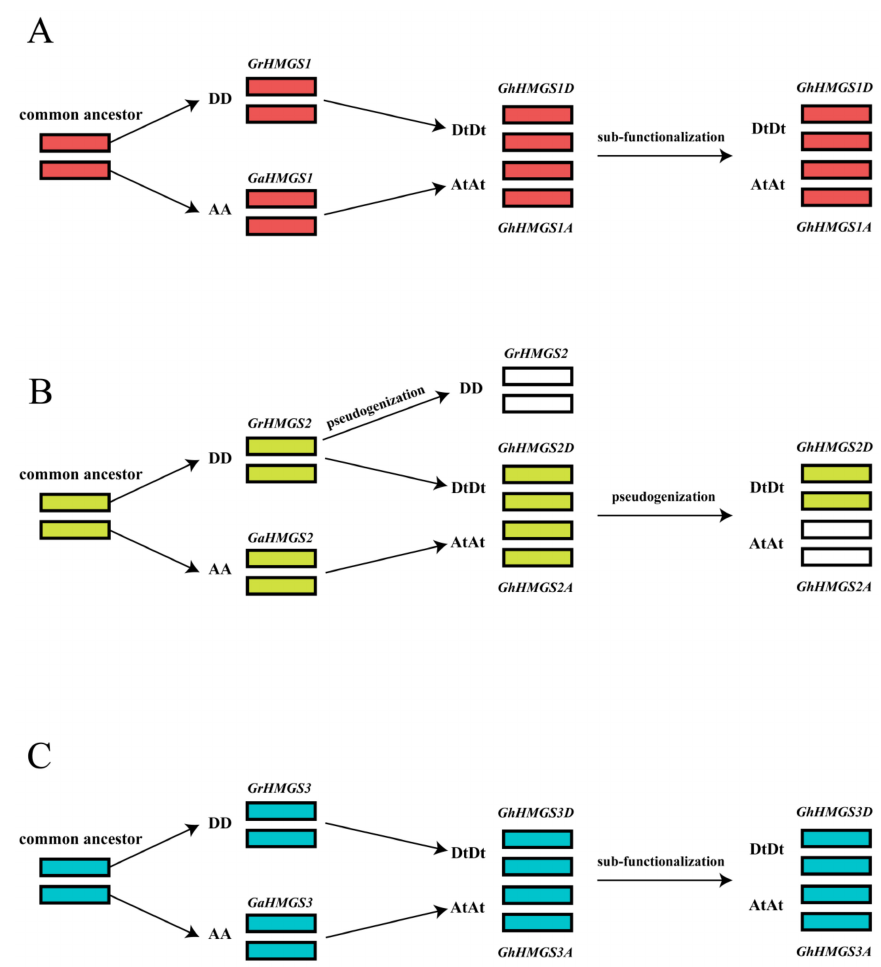
Figure 7. Inferred functional divergence of the duplicated HMGS genes in the allotetraploid cotton species, G. hirsutum . ( A ) Sub-functionalization of GhHMGS1A and GhHMGS1D , the red boxes represent genes encoding functional proteins; ( B ) pseudogenization of GhHMGS2A and GhHMGS2D , the yellow boxes represent genes encoding functional proteins and the white boxes represent the pseudogenes; ( C ) sub-functionalization of GhHMGS3A and GhHMGS3D , the blue boxes represent genes encoding functional